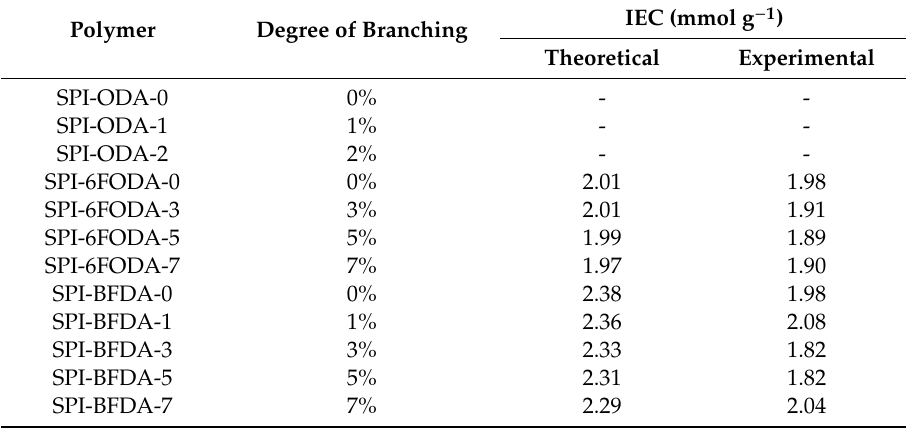
Table 3. Ion-Exchange Capacities (IECs), degree of branching values, and